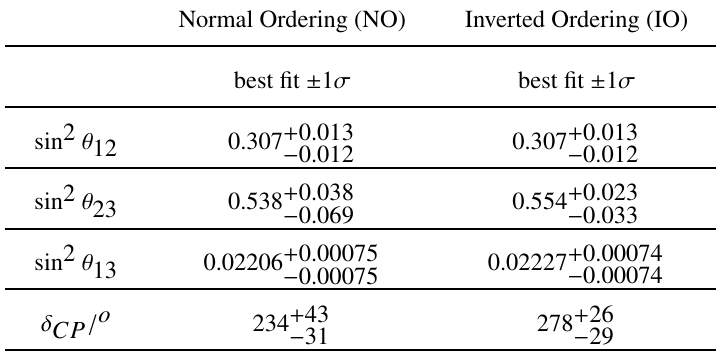
Table 4.1: The current best fit values from NuFit.org (Global fit framework for ν oscillation) on November